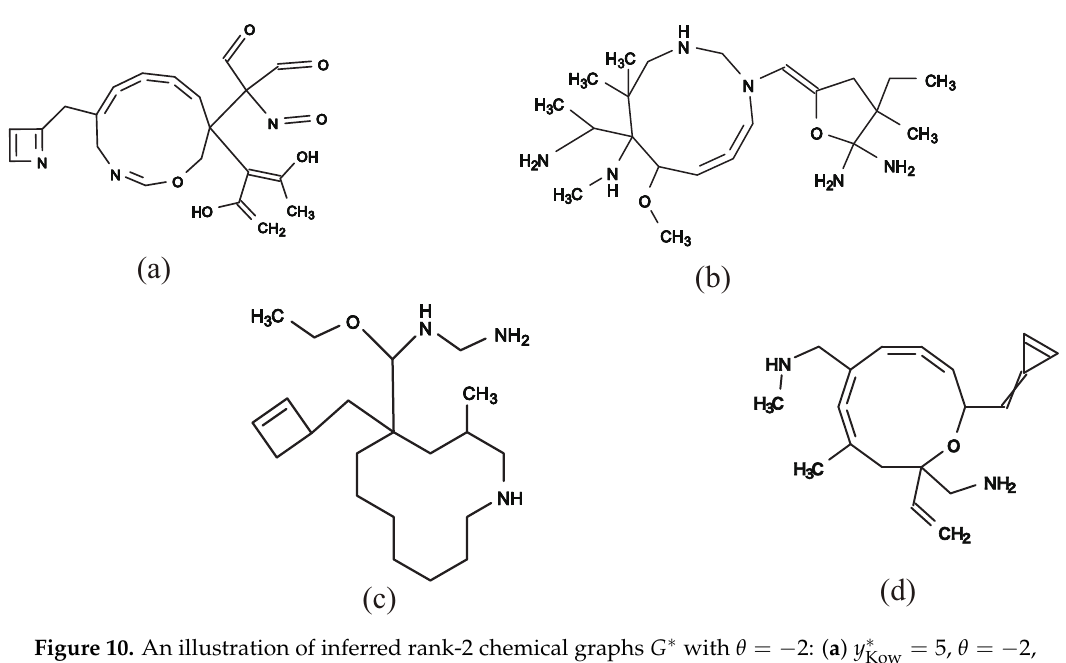
= 5, θ = − 2, Figure 10. An illustration of inferred rank-2 chemical graphs G ∗ with θ = − 2: ( a ) y ∗ Kow = 250, θ = − 2, n = 30, core size = 16, n = 30, core size = 16, core height = 3, d max = 4; ( b ) y ∗ Mp = 150, θ = − 2, n = 25, core size = 17, core height = 4, d max = 3; core height= 2, d max = 3; ( c ) y ∗ Bp